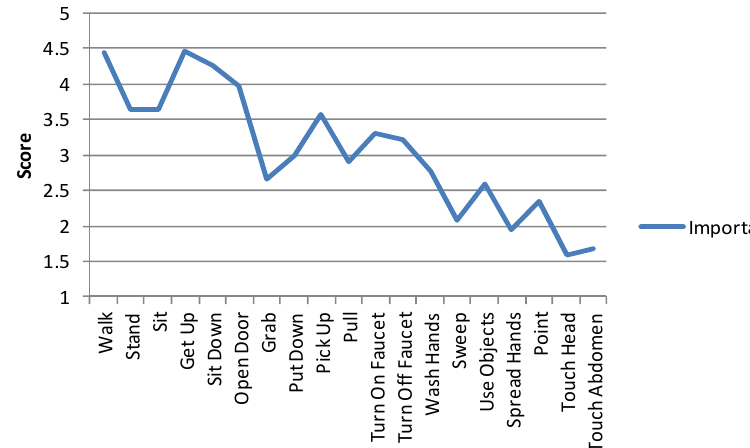
Figure 5. Average importance of each activity assessed by all